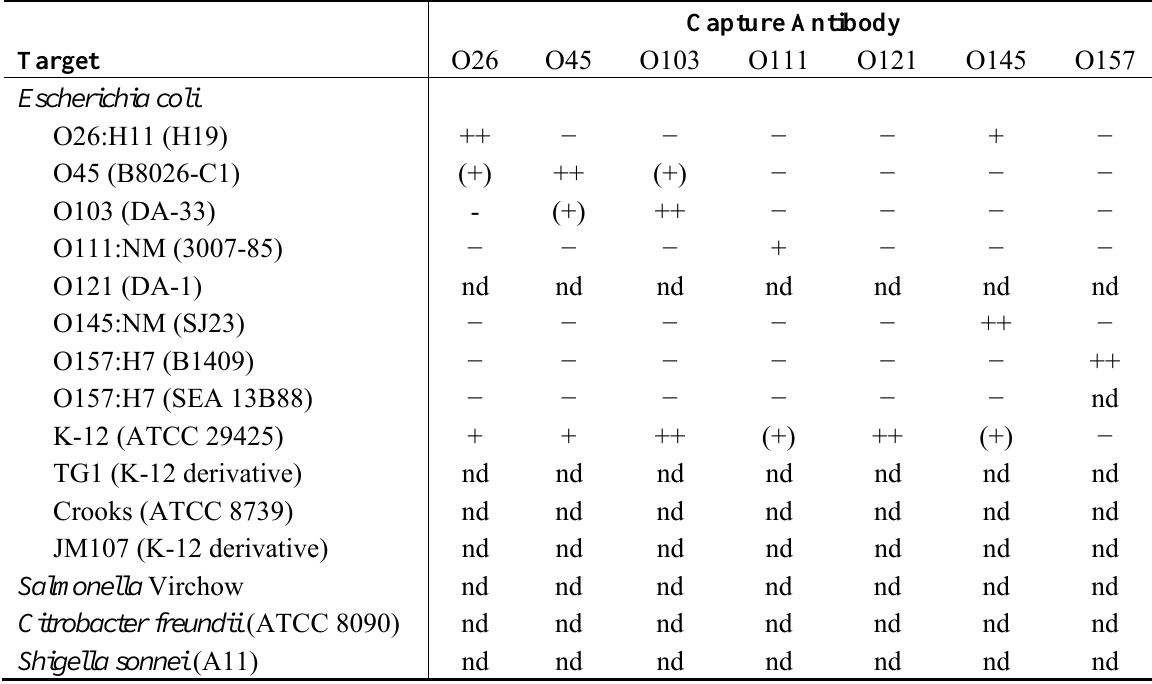
Table 4. Semi-quantitative microarray responses for target and non-target bacterial samples ( ca. 1 × 10 8 CFU/mL) reacted with high dilutions (1:500 to 1:1000) of PSU purified IgGs. (Key: − = no binding; (+) = faint binding; + = binding; ++ = high binding, nd = not